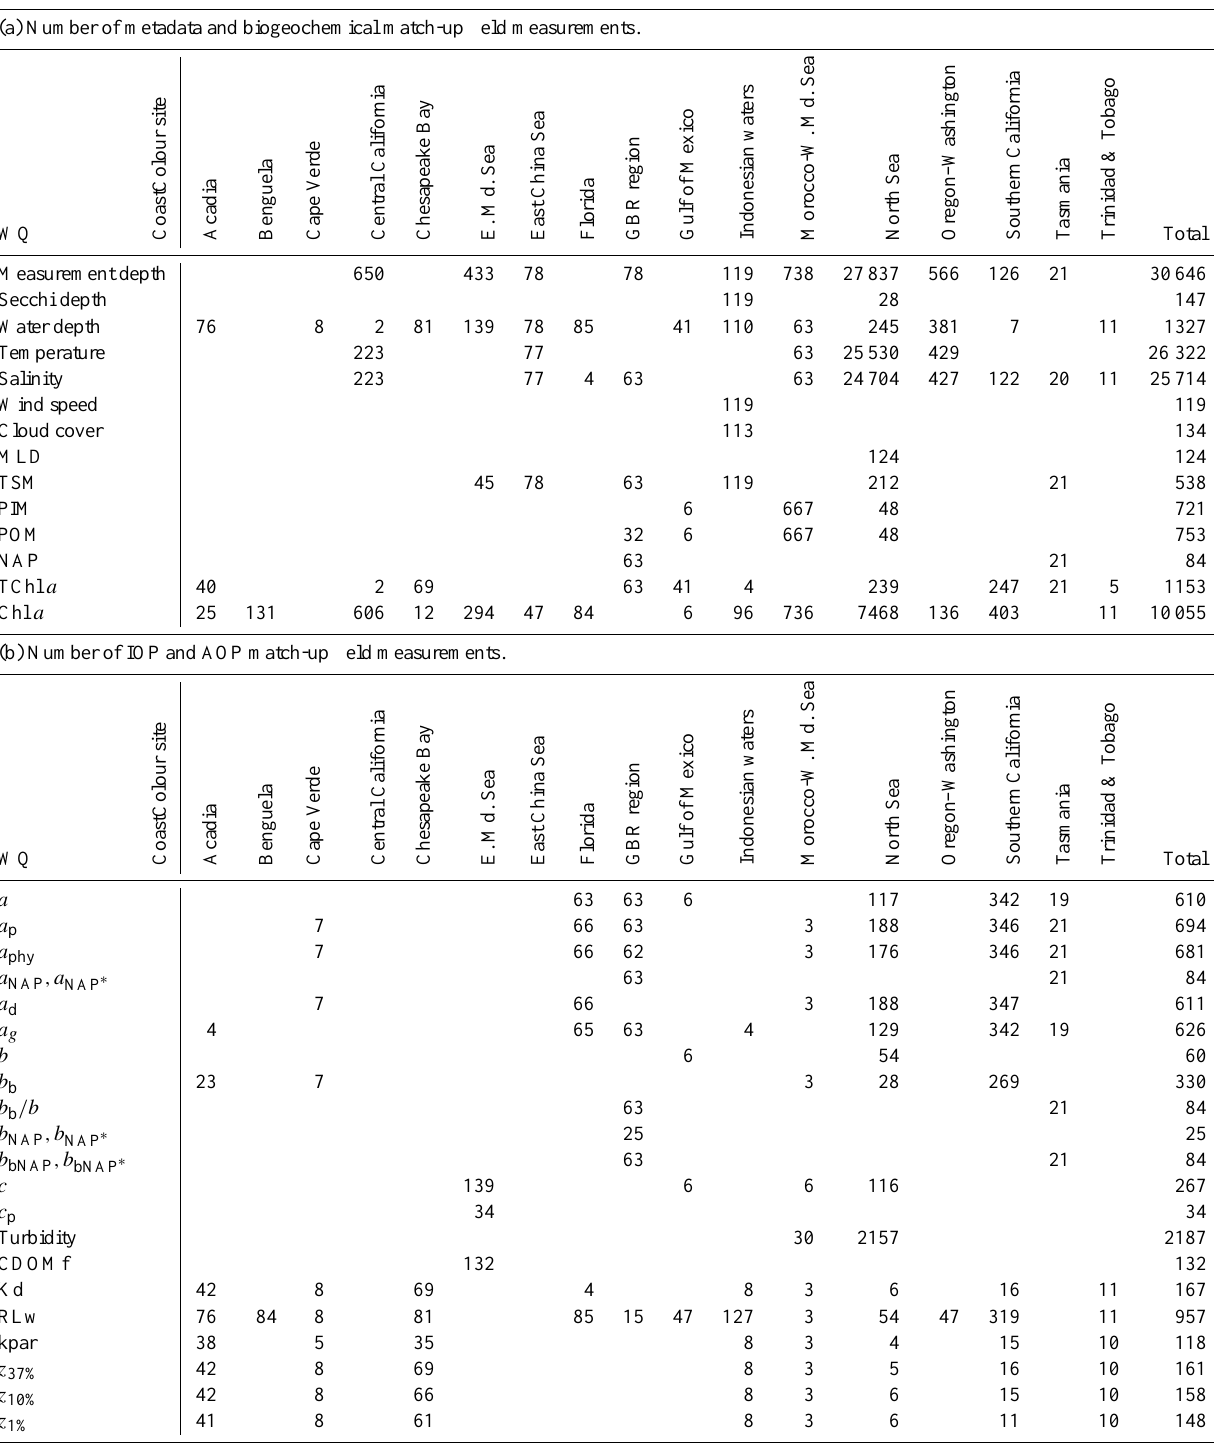
Table 3. Number of matchup-up field measurements provided by parameter (lines) and by site (columns). (a) Number of metadata and biogeochemical match-up field measurements.